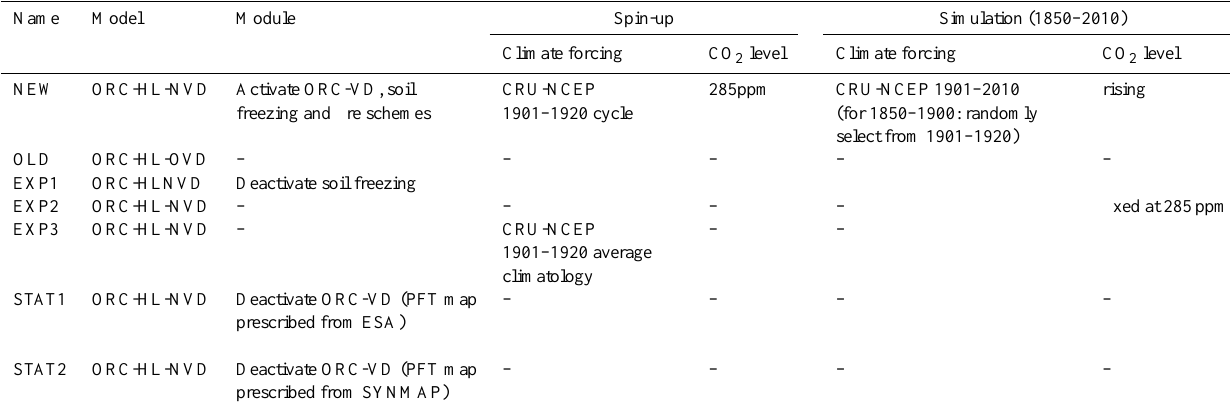
Table 2. Characteristics of each ORC-HL offline run. OLD follows the same simulation protocol as NEW. EXP1–3 and STAT are similar to NEW except for one different setting for each